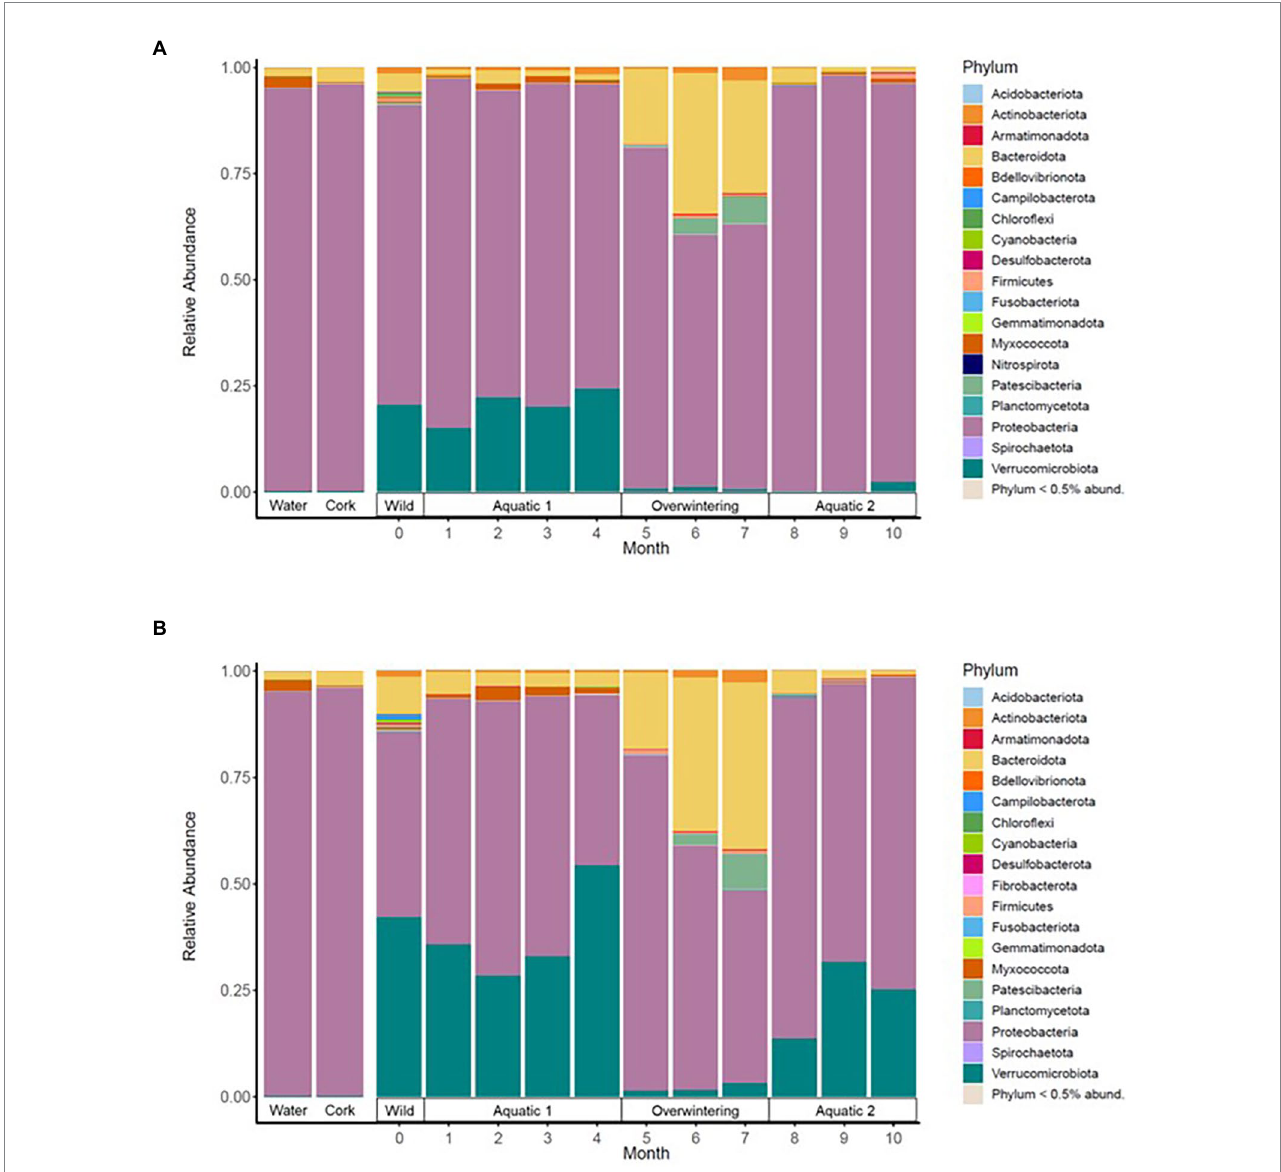
FIGURE 2 Mean relative abundance of the most frequent bacterial phylotypes in the skin microbiota of alpine (A) and palmate (B) newts, at the phylum level, across time of the experiment. Dominant phyla are identified in the legend. Environmental controls were sampled from the water filled in the aquaria (Water) and the pieces of cork (Cork) placed in the overwintering